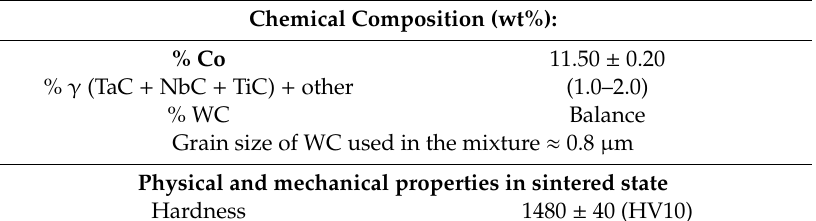
Table 4. Chemical composition and physical and mechanical properties (PALBIT).